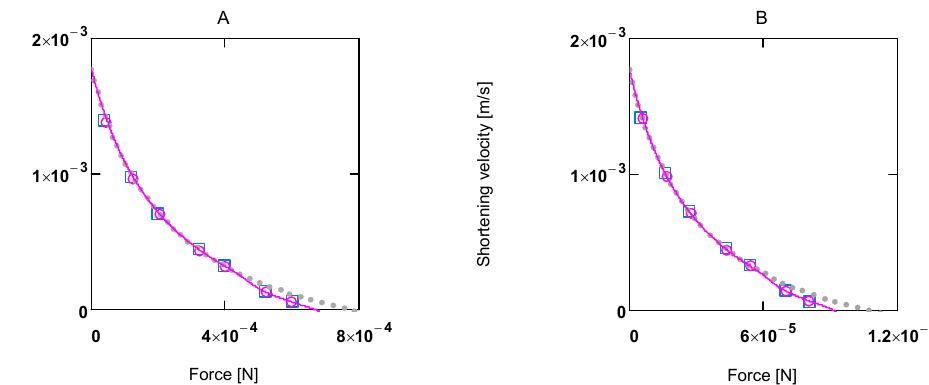
Figure 2. Shortening velocity as a function of load force at two different Ca 2+ concentrations A: [Ca 2+ ] = 1.08 µM; (light grey dots) according to equation 10b; (red line) versus load force; (blue equation 10b plus uncoupling; (red circles) results from SIM GLYgen versus load force as sensed by cross-bridges; B: as in A , squares) results from SIM GLYgen but at [Ca 2+ ] =